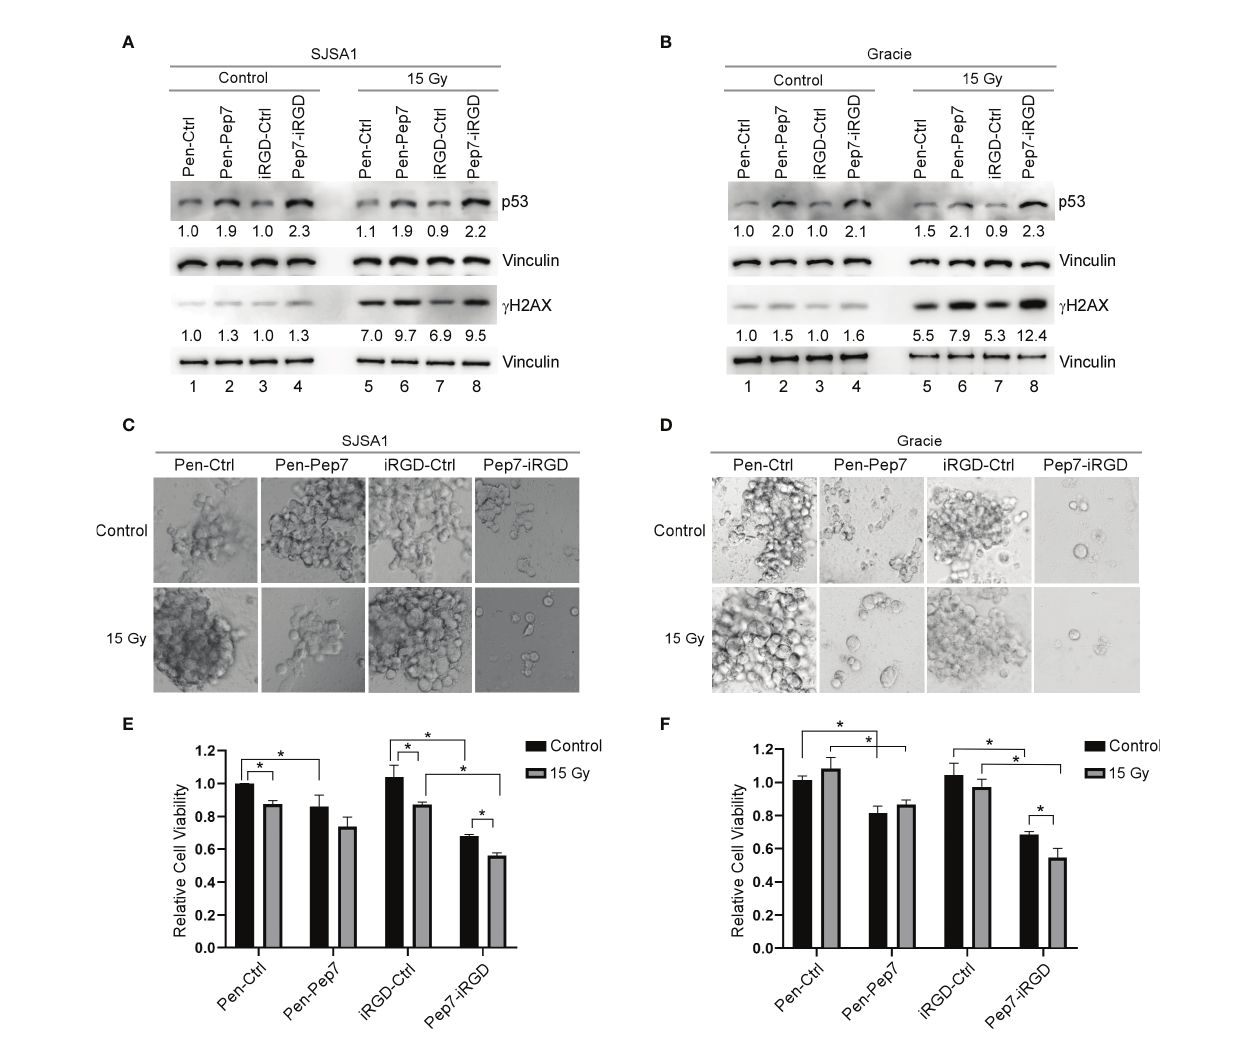
FIGURE 6 | Pep7 sensitizes human and canine OSA cells to radiation. (A, B) The levels of p53, g H2AX, and vinculin were measured in human OSA (SJSA1) and canine OSA (Gracie) cell lines treated with Penetratin or iRGD delivered peptides (20 µM) alone or in combination with 15 Gy radiation. (C – F) 3D spheroid cultures and relative cell viability were measured in SJSA1 (C, E) and Gracie (D, F) cells after treatment with peptide alone (20 µM) or in combination with 15 Gy radiation. Spheroids were imaged with a 10x microscope objective. Values represent the mean ± SEM of three independent experiments (*, P <